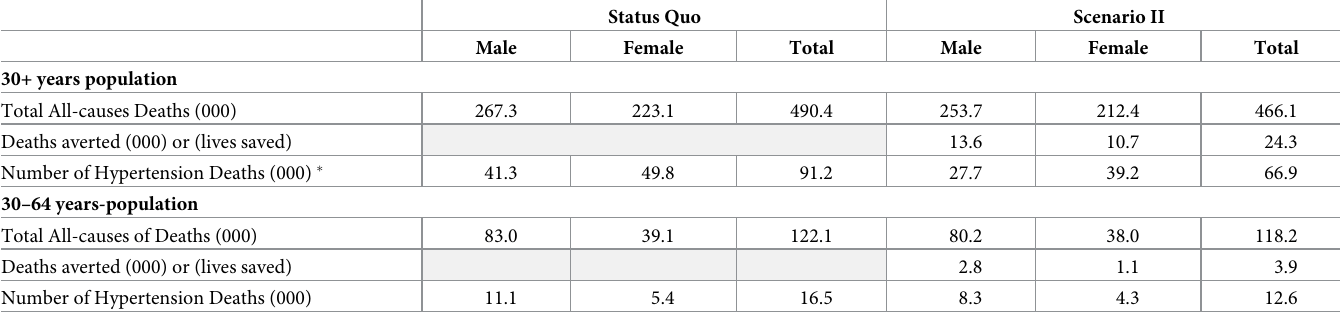
Table 6. Projected total and hypertension deaths in 2030.